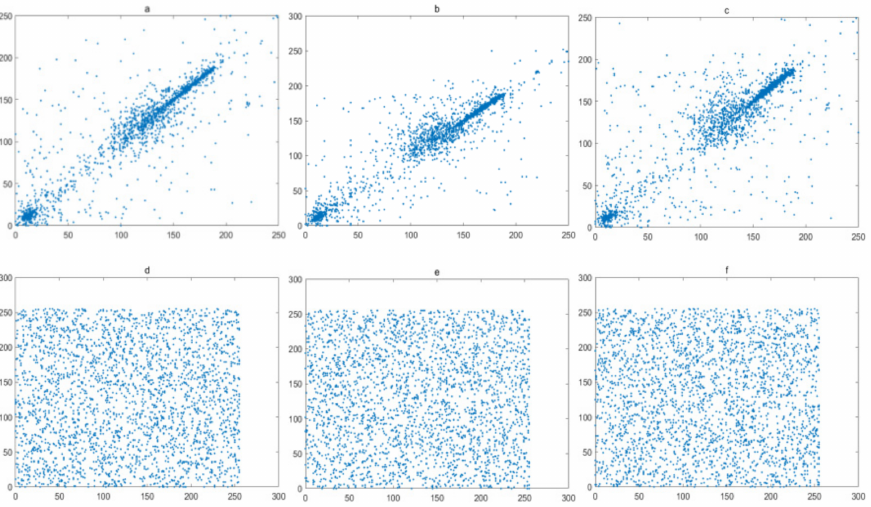
Figure 17. Correlation analysis of Cameraman image: ( a – c ) horizontal, vertical and diagonal direction of plain-text image; ( d – f ) horizontal, vertical and diagonal direction of